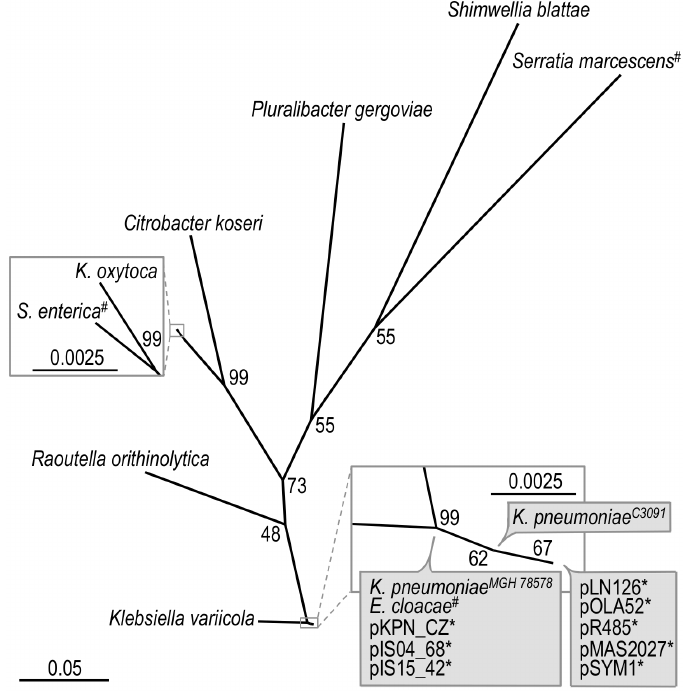
Fig 5. Maximum likelihood phylogeny based on the nucleotide sequence of PapD_N and PapD_C of mrkB . ( * ) Indicates that mrkB is encoded on a plasmid. ( # ) Indicates that mrkB may be part of a putative genomic island. Percentages of bootstrap support (1000 replicates) are